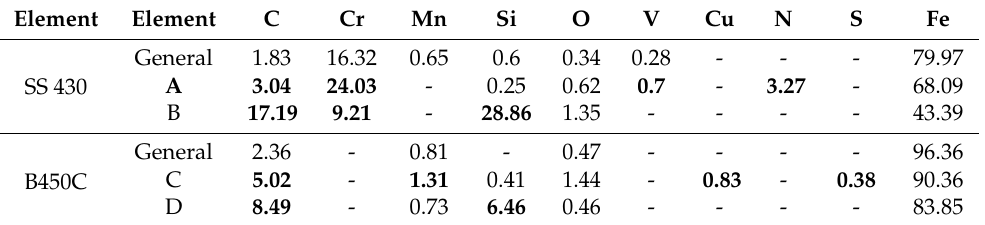
Figure 1. SEM images ( × 500) of surface steel control samples and zoom ( × 3000) of areas of interest: ( a ) SS 430 and ( b ) carbon steel B450C. Table 2. EDS surface analysis (wt.%) of SS 430 (Figure 1a) and carbon steel B450C (Figure 1b) control samples.